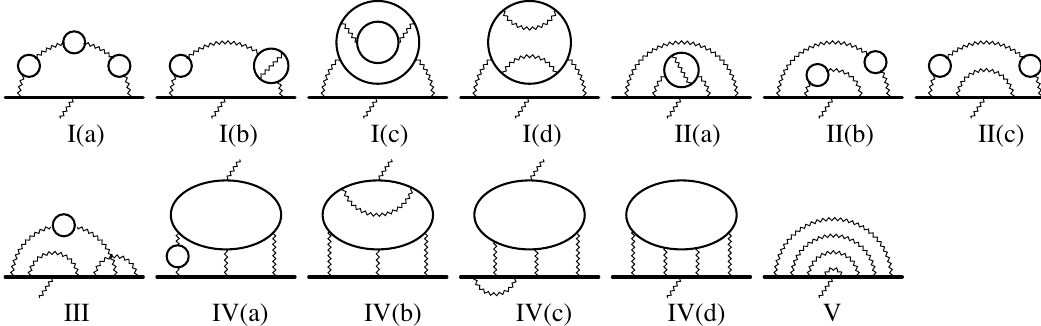
Figure 4. Eighth-order vertex diagrams. There are 891 diagrams in total, and they are divided into 13 gauge-invariant subsets of five super sets. A typical diagram from each subset is shown as I ( a – d ), II ( a – c ), III , IV ( a – d ), and V . There are I(a) 1 diagram, I(b) 6 diagrams, I(c) 3 diagrams, I(d) 15 diagrams, II(a) 36 diagrams, II(b) 6 diagrams, II(c) 12 diagrams, III 150 diagrams, IV(a) 18 diagrams, IV(b) 60 diagrams, IV(c) 48 diagrams, IV(d) 18 diagrams, and V 518 diagrams. The straight and wavy lines represent electron and photon propagators, respectively. Reprinted from